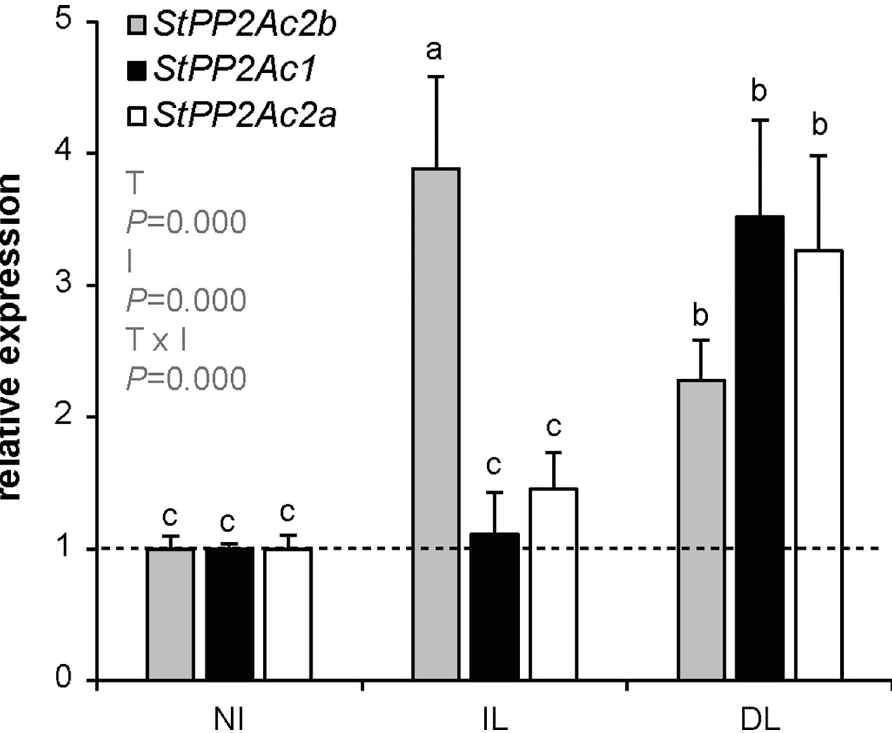
Fig 1. Expression analysis of StPP2Ac2b , StPP2Ac2a and StPP2Ac1 in wild type potato plants infected with P . infestans . Plants were inoculated with P . infestans as described in Materials and Methods. After four dpi, expression was determined by RT-qPCR in leaves from non-infected plants (NI), infected leaves (IL) and distal leaves (DL), relative to NI (dashed line). Data are the mean ± SEM of of three independent experiments. Data were analyzed by two-way ANOVA, followed by Bonferroni post-hoc test ( α = 0.05) comparing the expression of each gene between NI, IL and DL, and the expression of the different genes within each experimental condition (NI, IL or DL). P -values of the effects of treatment (T: NI, IL, DL), StPP2Ac isoform type (I: StPP2Ac2b , StPP2Ac1 , StPP2Ac2a ) and their interaction are shown. The two-way ANOVA revealed a significant interaction between the effects of T and I, and a significant effect of T and I on the expression levels of StPP2Ac.